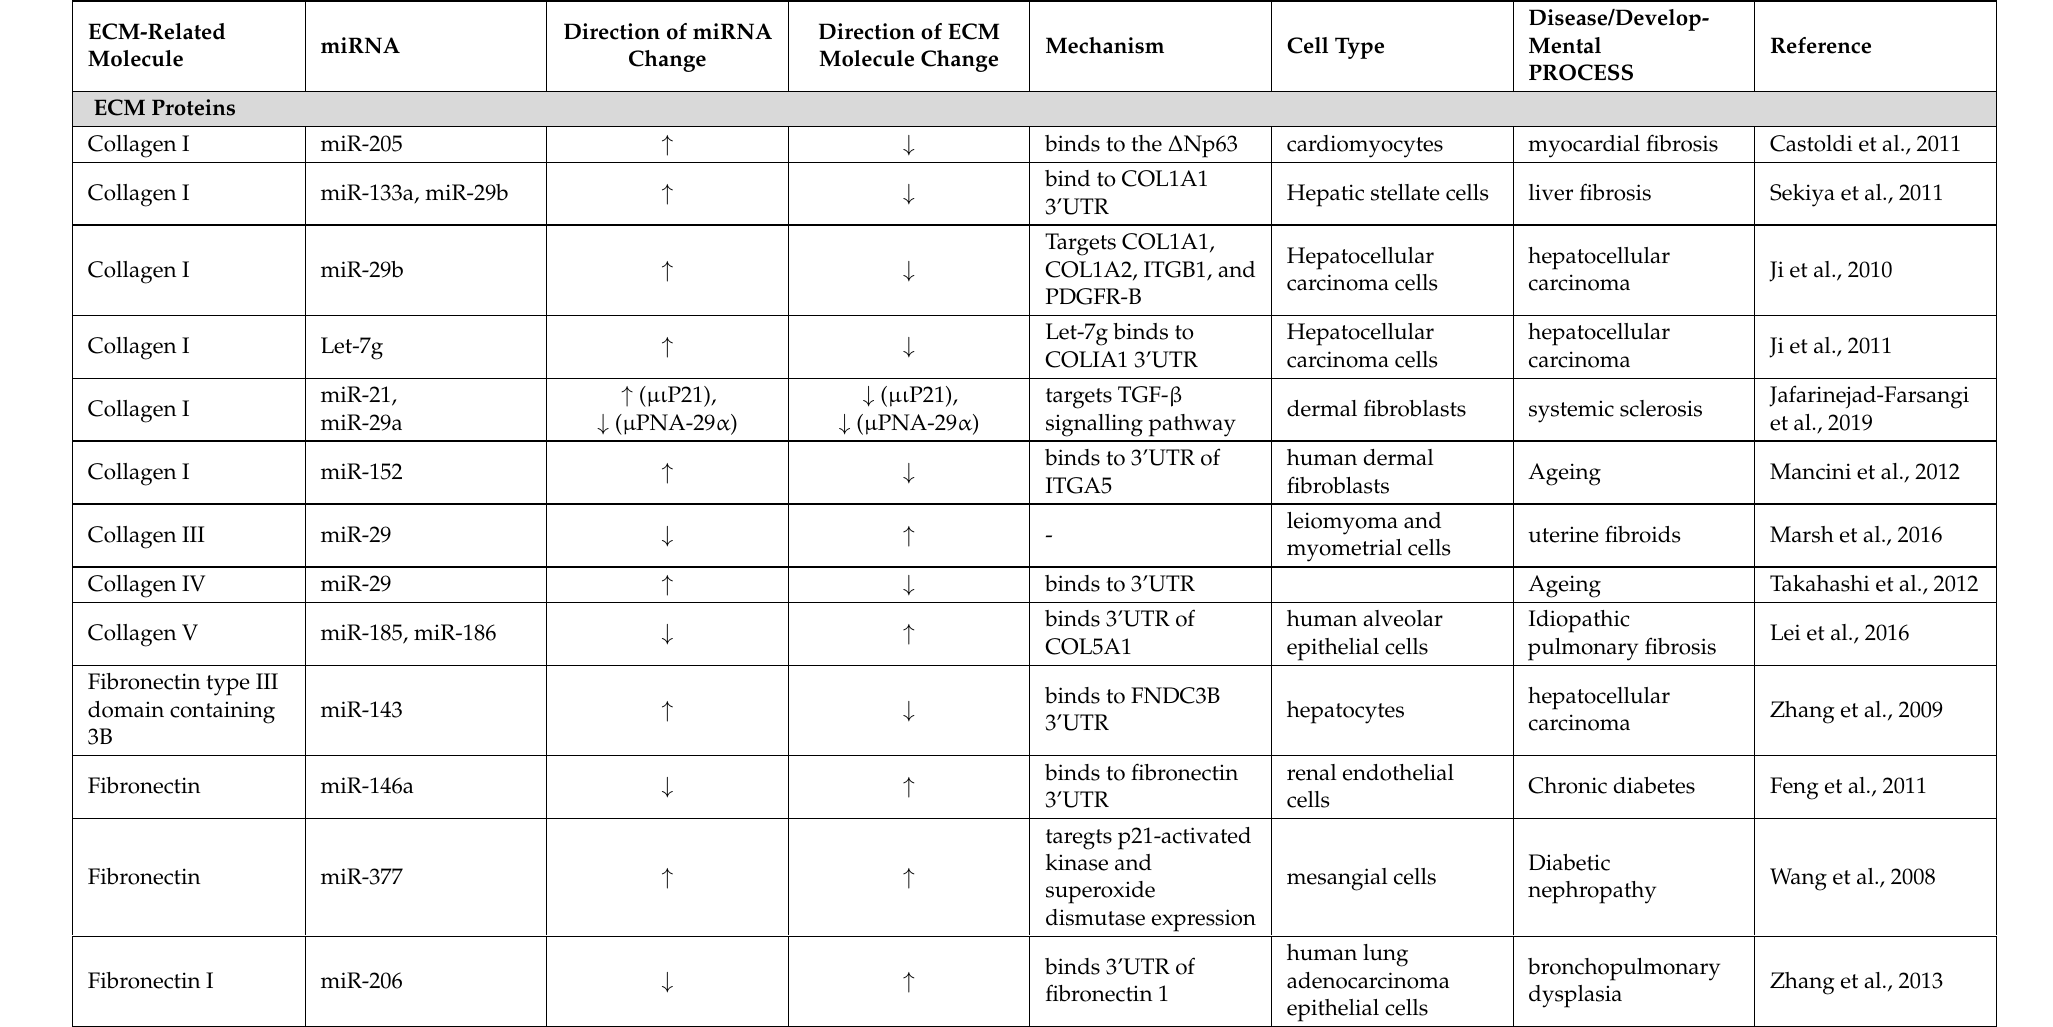
Table 1. Regulation extracellular matrix remodeling by